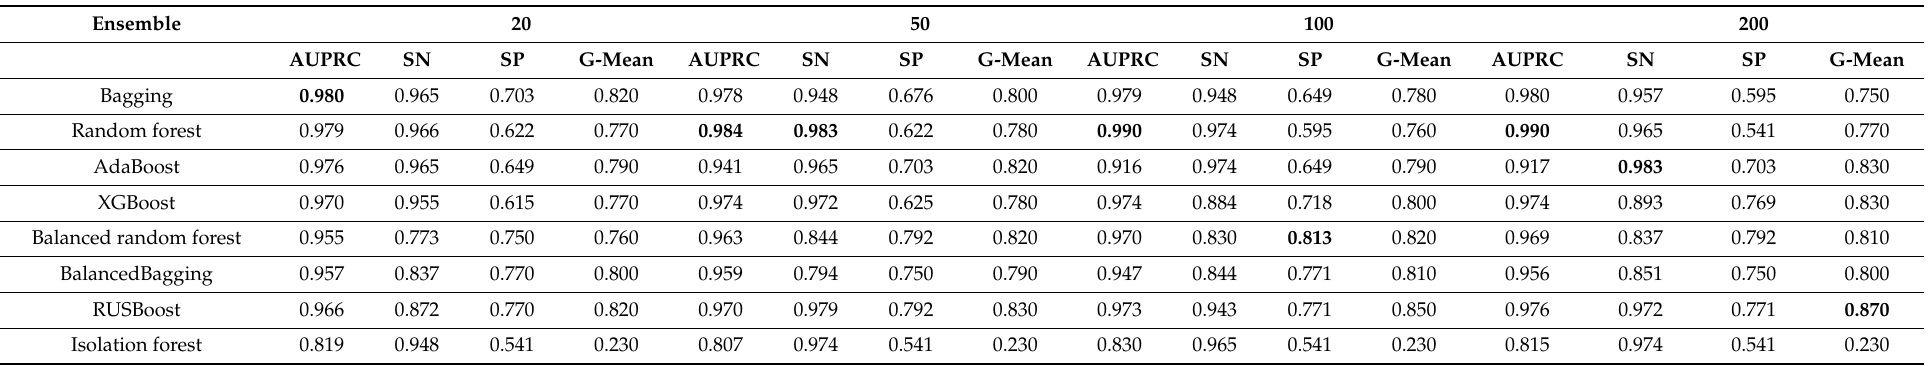
Table 9. The AUPRC, SN, SP, G-Mean performance metrics of different ensembles of classifiers (decision trees) with various sizes of ensembles (Bold numbers show the best